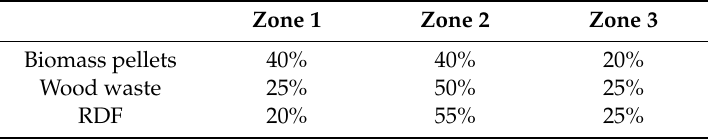
Figure 5. Contour of solid temperature for combustion of: ( a ) biomass pellets, ( b ) wood waste, ( c ) refuse-derived fuel (RDF). Table 4. Primary air distribution of biomass combustor for di ff erent